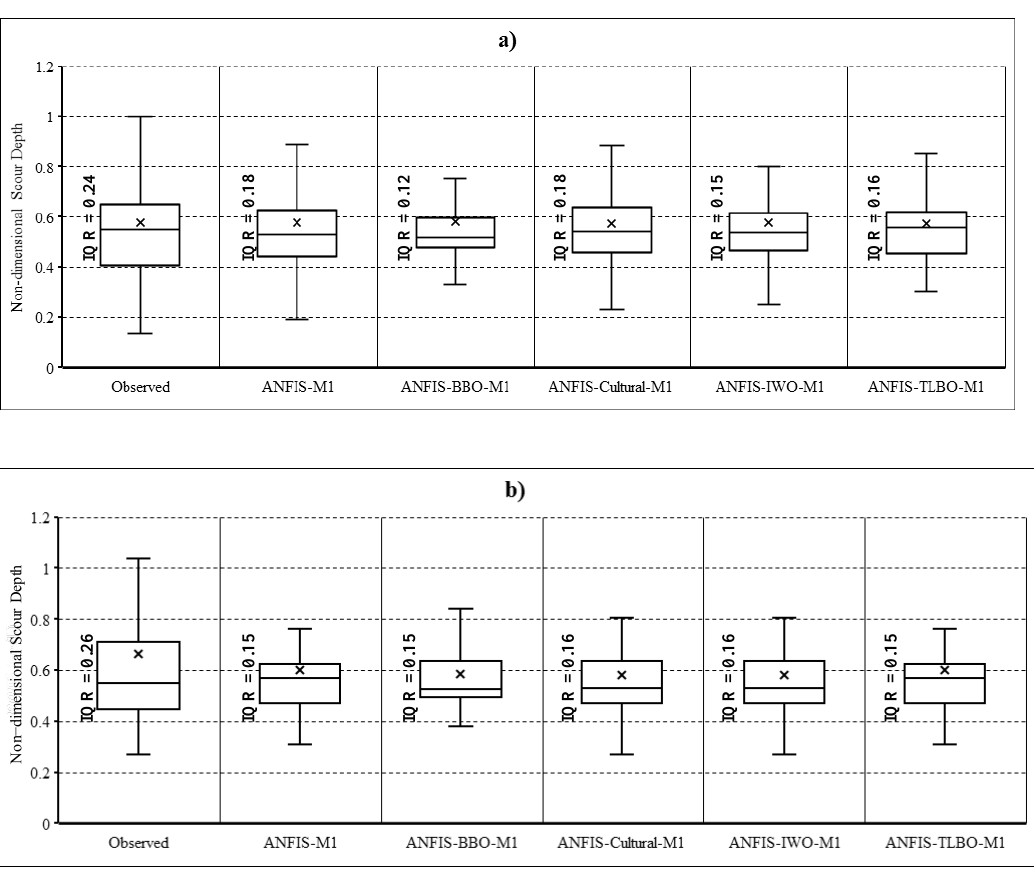
Figure4. Boxplotsofthepredictedagainstobservedscouringdepth: ( a )trainingphase, ( b Figure 4. Boxplots of the predicted against observed scouring depth: ( a ) training phase, ( b ) testing phase.